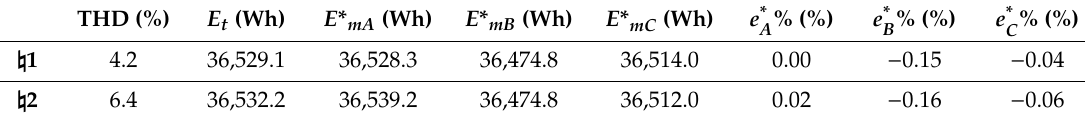
Table 6. EMUTs additional percentage error at random distorted current and voltage